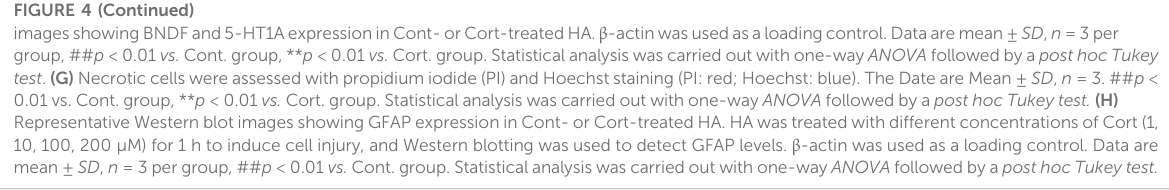
(Figure 7A), downregulated the levels of RIPK1/p-RIPK1, RIPK3/ p-RIPK3 and MLKL/p-MLKL (Figures 6C, D), reversed the CUMS- induced reduction in the levels of 5-HT1A and BDNF (Figure 7C), inhibited CUMS-mediated in fl ammatory cytokine release (Supplementary Figure S3A), and downregulated the immunostaining of RIPK1 or RIPK3 in GFAP-positive astrocytes in the hippocampus of mice (Figures 6E, F). Similarly, FLX treatment inhibited the levels of necroptotic kinases, including RIPK1/p-RIPK1, RIPK3/p-RIPK3 MLKL/p-MLKL, in the Cort-induced human astrocyte injury model (Figures 6A, B), reversed the Cort-induced reductionincell viability (Figure7D) and theCort-induced increase in the proportion of propidium iodide (PI)-positive cells (Figure 7B), increased the protein levels of GFAP (Figure 7A), BDNF and 5-HT1A (Figure 7E), and decreased the Cort-induced release of in fl ammatory cytokines from human astrocytes (Supplementary Figure